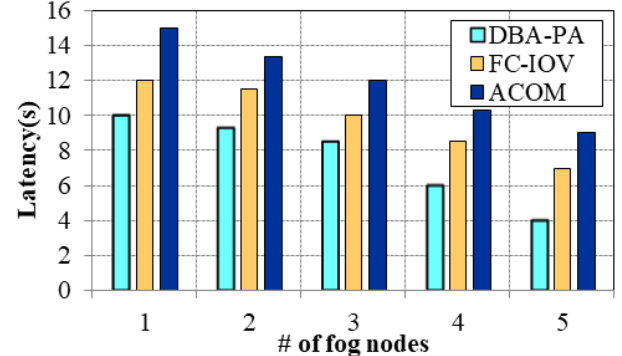
Figure 12. Number of Fog Nodes vs. Latency.